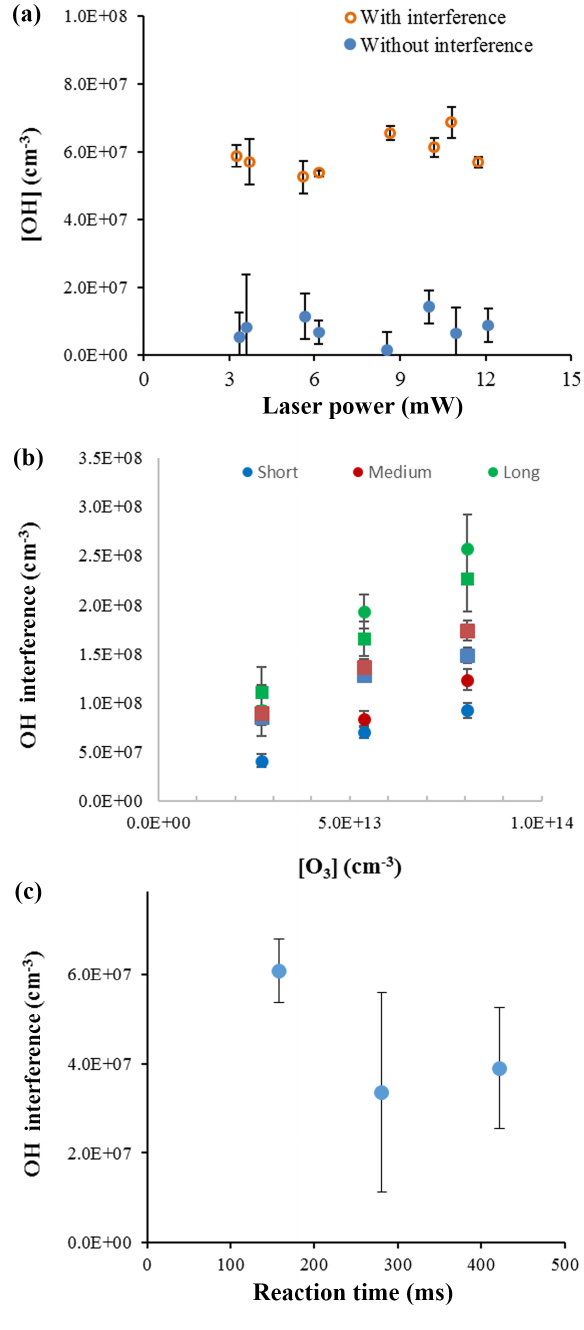
Figure 5. OH concentrations from ocimene ozonolysis with varied laser power at an ozone mixing ratio of 2ppm and ocimene concen- tration of approximately 3 × 10 13 cm − 3 (a) . OH interference dur- ing α -pinene (approximately 3 × 10 12 cm − 3 , circles) and ocimene (approximately 3 × 10 13 cm − 3 , squares) ozonolysis based on ozone concentration and inlet length (b) . OH interference measurements during ocimene ozonolysis as a function of reaction time with an ocimene concentration of approximately 3 × 10 13 cm − 3 (c)